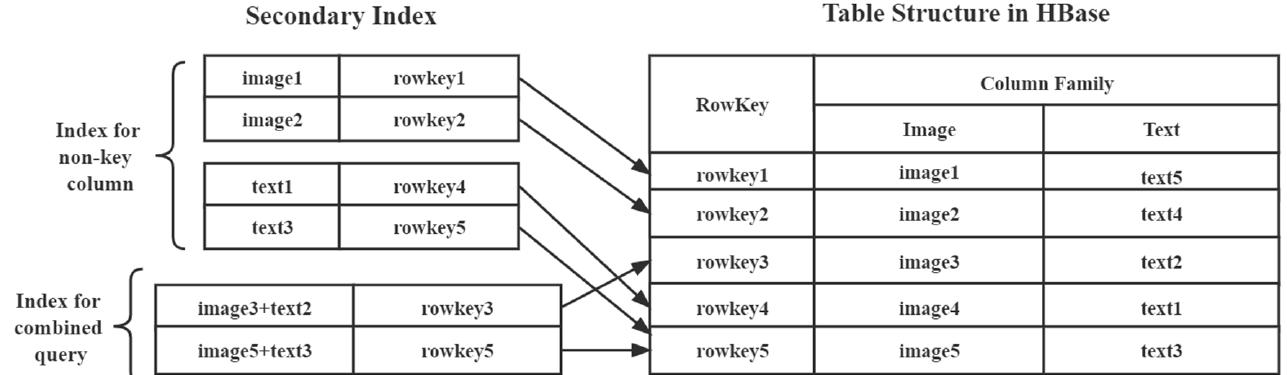
Figure 5. The secondary index in HBase.